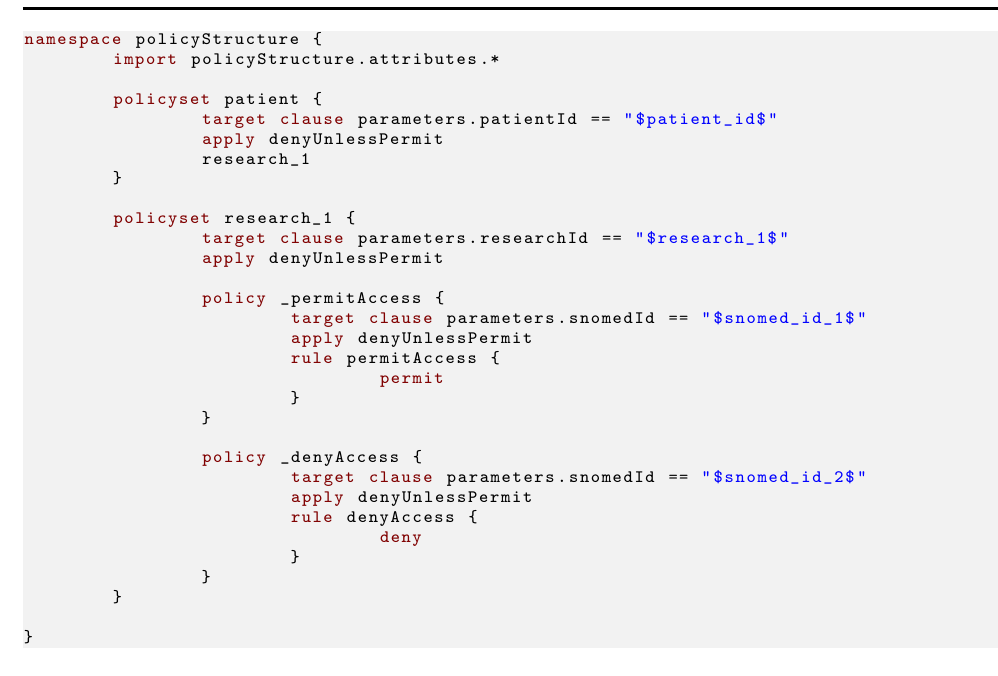
Listing 1. Final policy structure in ALFA